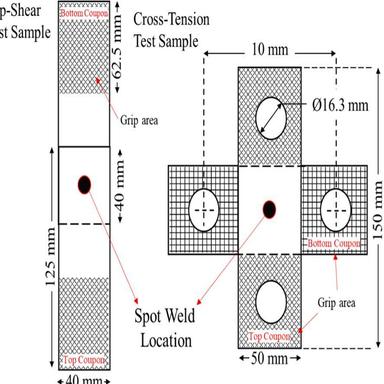
Lap-shear and cross-tension test sample geometries and dimensions.